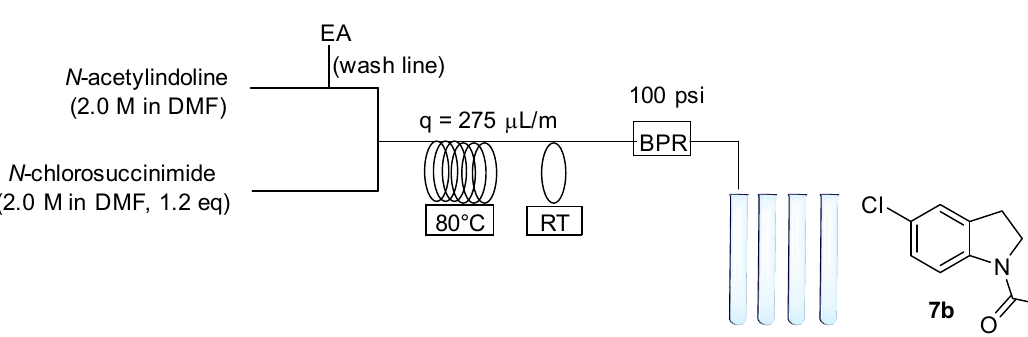
Scheme 1. Synthesis of N -acetyl-5-bromo-6-sulfonamide indoline derivatives.